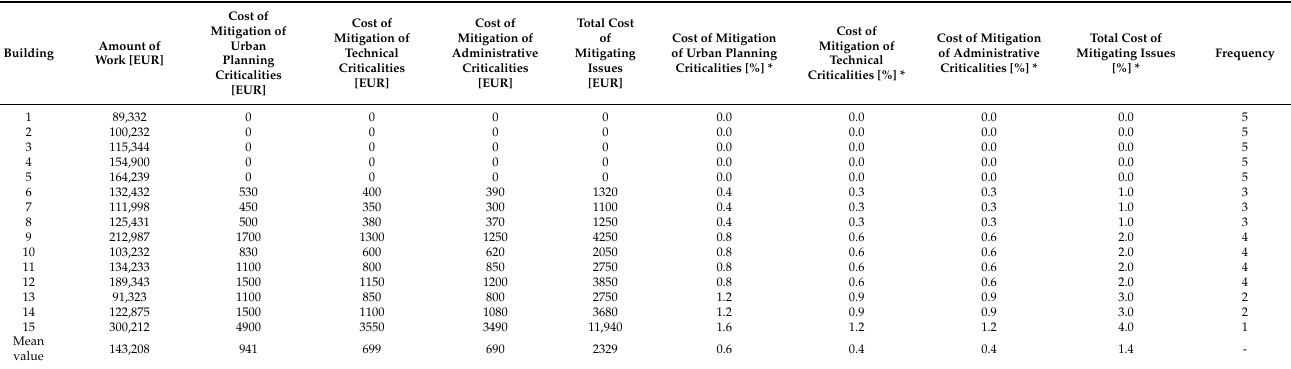
Table 5. Definition of the percentage costs of urban, technical, and administrative criticalities as a percentage of the amount of the works for the 15 projects carried out on small buildings (single-family and